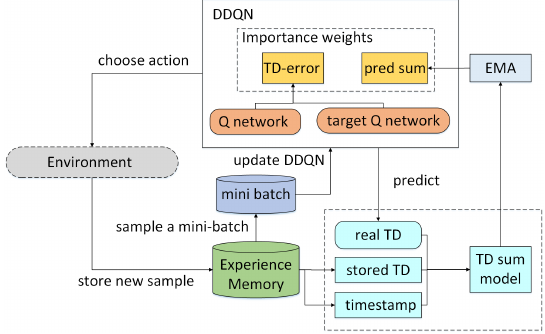
Figure 3. The architecture of the Imp-PER on